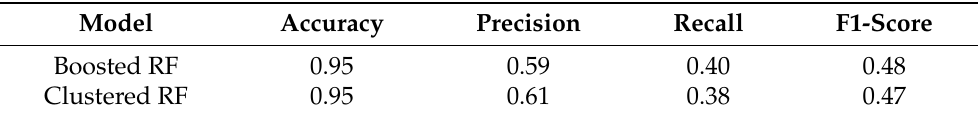
Table 3. Accuracy, Precision, Recall, and F1 Score for the prediction of patient mortality on CDC case surveillance data.